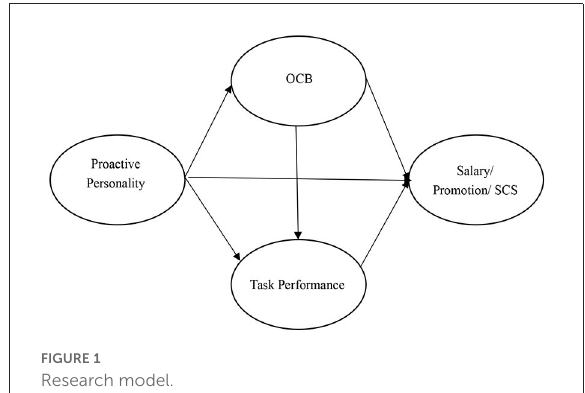
FIGURE1 Research